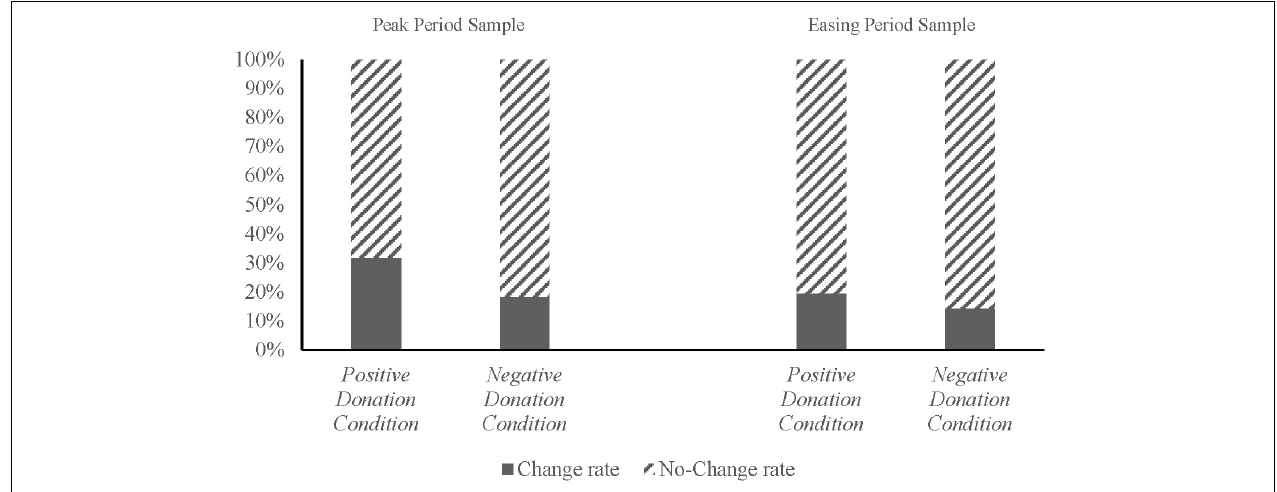
FIGURE 1 | Change rates of the decisions of the participants in the positive and negative donation conditions.